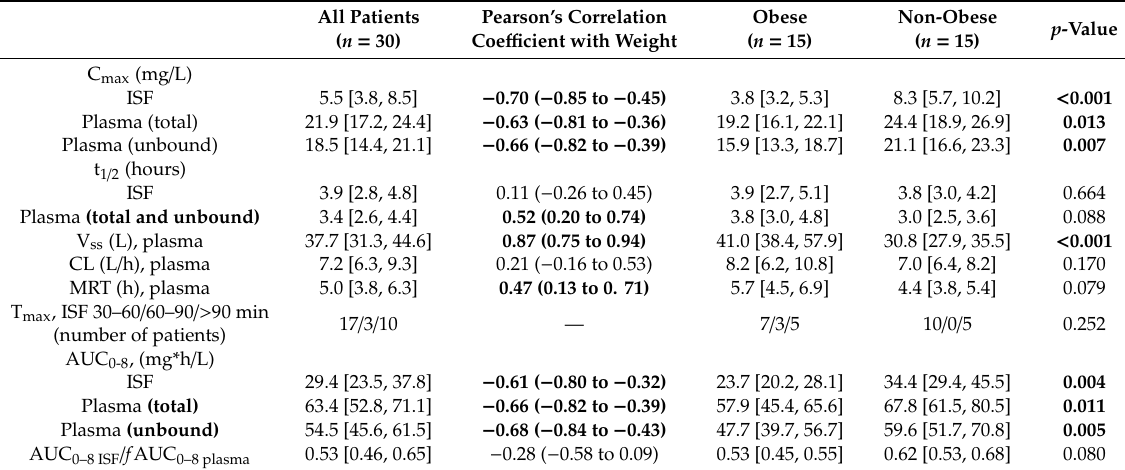
Table 2. Pharmacokinetic parameters for linezolid. Entries are the median [interquartile range], estimate (95% confidence interval), or count (%). The p -values refer to comparisons of the obese and non-obese groups. AUC = area under the concentration–time curve; CL = total body clearance; ISF = interstitial fluid of the subcutaneous adipose tissue; MRT = mean resistance time; V ss = volume of distribution at a steady state; C max = maximum concentration; t 1 / 2 = half-life; T max = time point of C max . Bold type indicates significant values.